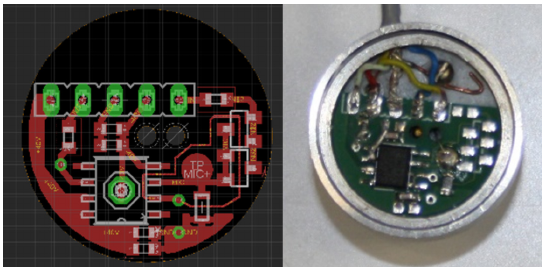
Figure 10. Board design ( left ) and mounting of the printed circuit board inside the Brüel & Kjær AQ-0015 adapter ( right ).